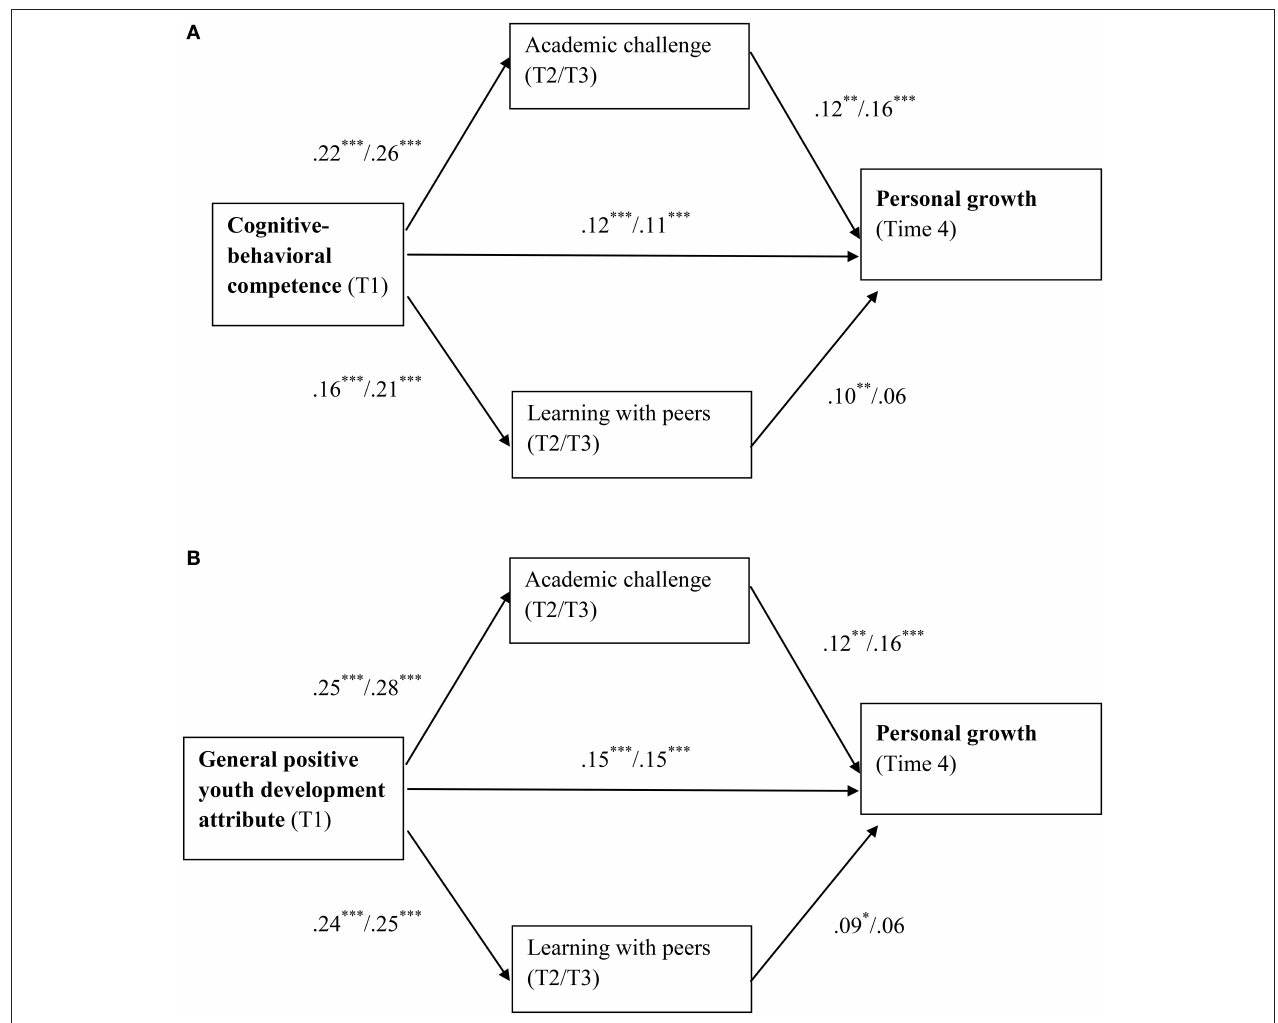
FIGURE 2 | (A) Relationships among cognitive-behavioral competence, personal growth, and internal dimensions of university engagement. T1 = Time 1; T2 = Time 2; T3 = Time 3; T4 = Time 4. The regression coefficients shown in the figure are unstandardized values with values before and after slash representing using Time 2 and Time 3 internal dimensions of university engagement, respectively. (B) Relationships among general positive youth development attribute, personal growth, and internal dimensions of university engagement. T1 = Time 1; T2 = Time 2; T3 = Time 3; T4 = Time 4. The regression coefficients shown in the figure are unstandardized values with values before and after slash representing using Time 2 and Time 3 internal dimensions of university engagement, respectively. * p < 0.05; ** p < 0.01; *** p <